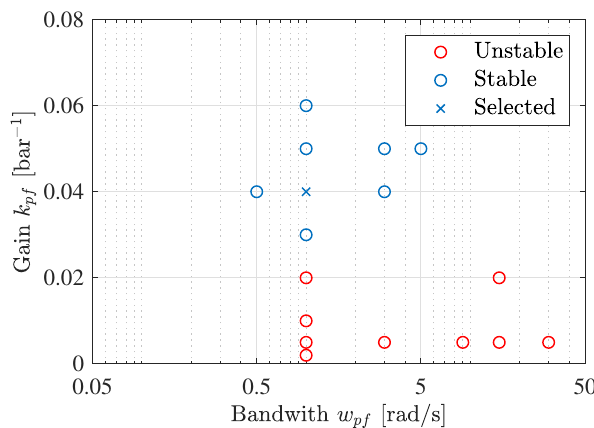
Figure 24: Stable and unstable pressure feedback con- figurations in the laboratory.